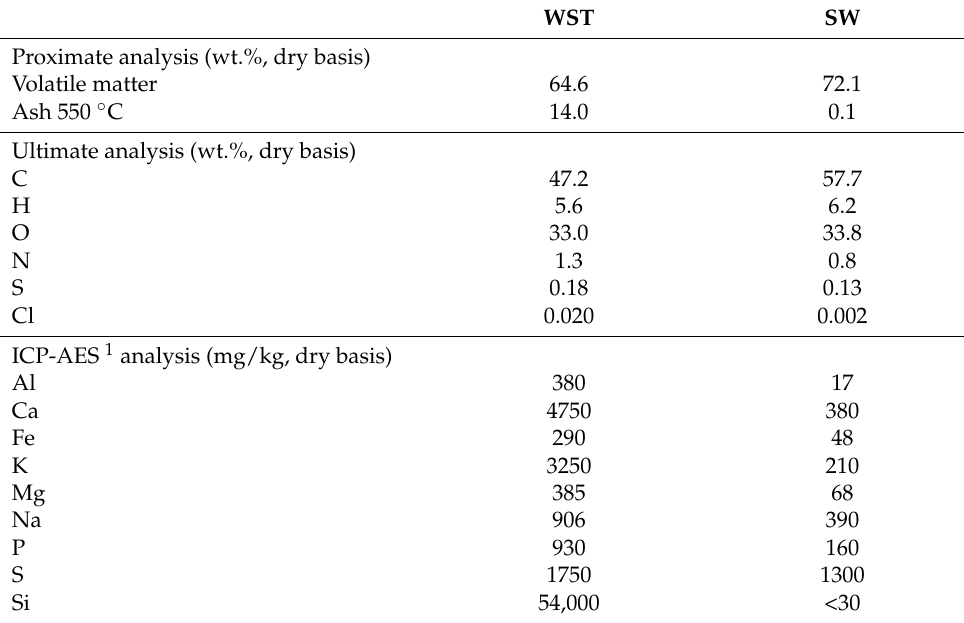
Table 1. Proximate, ultimate and ash compositions of WST and SW